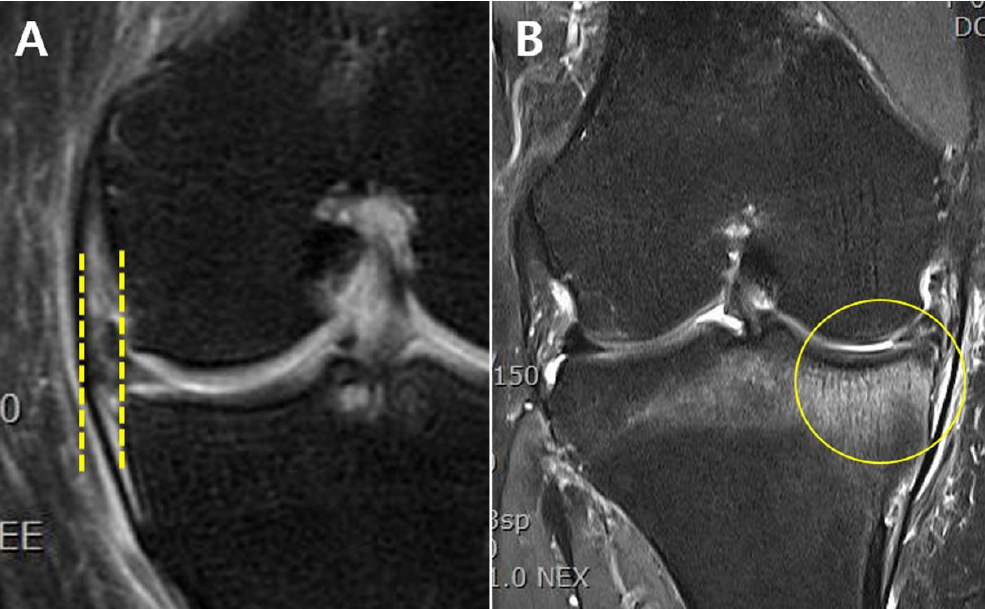
Figure 1. ( A ) Extrusion of the medial meniscus in a left knee. Meniscal extrusion was a distance between two vertical lines touching the edges of the tibial plateau and the meniscus. Meniscal extrusion exceeding 3 mm was counted. ( B ) Subchondral BML of the medial tibial plateau in a right knee. The lesion was a locus of high signal intensity with trabecular marrow in it. BML, bone marrow lesion.